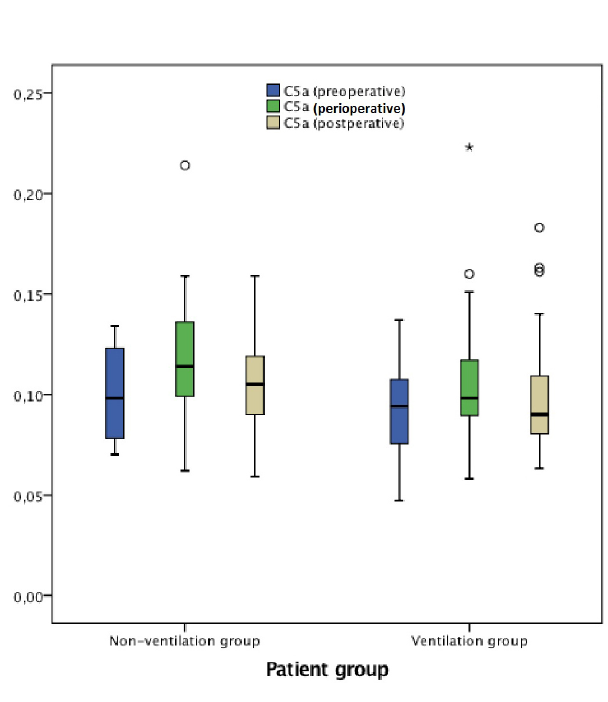
Fig. 3 - IL-8 measurements in preoperative (pre-CPB), perioperative (during CPB) and postoperative (post-CPB) periods.